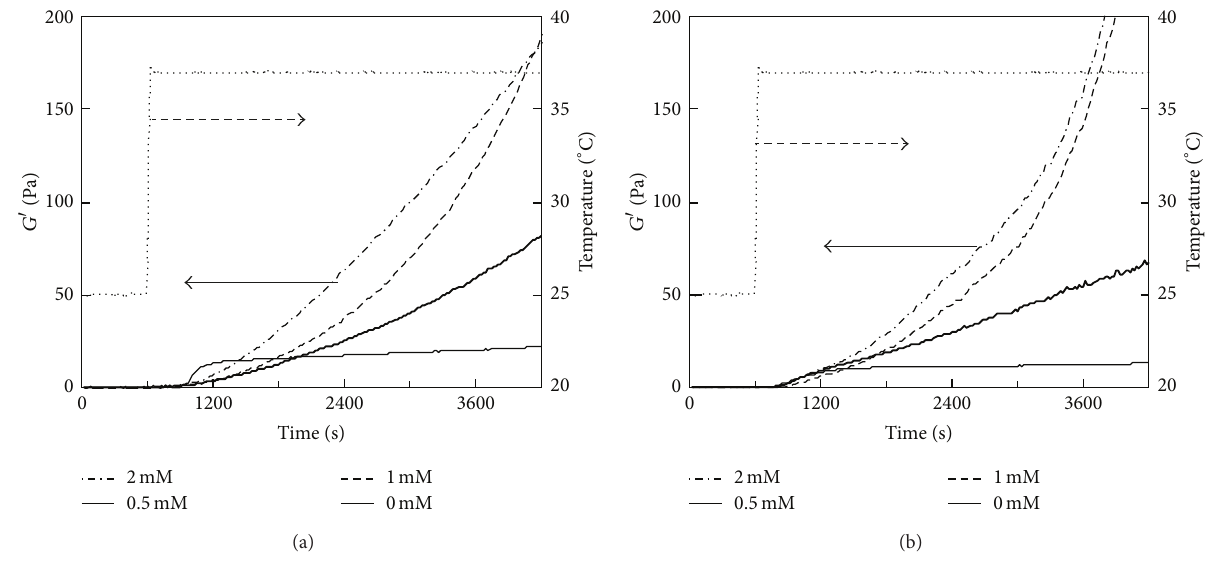
Figure 7: Storage modulus ( G 󸀠 ) of the 0.5% PSC/genipin solution measured by a temperature-responsive gelation test. The temperature was maintained at 25 ∘ C for 600s and then increased to 37 ∘ C. Numbers in figures indicate genipin